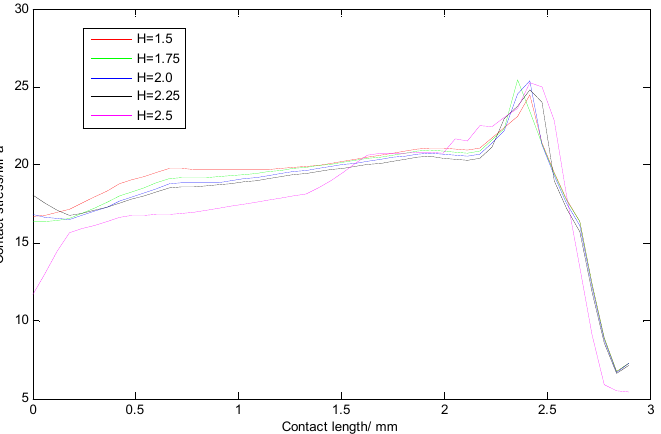
Figure 7. Distribution of contact stress along contact path at I at different thicknesses H